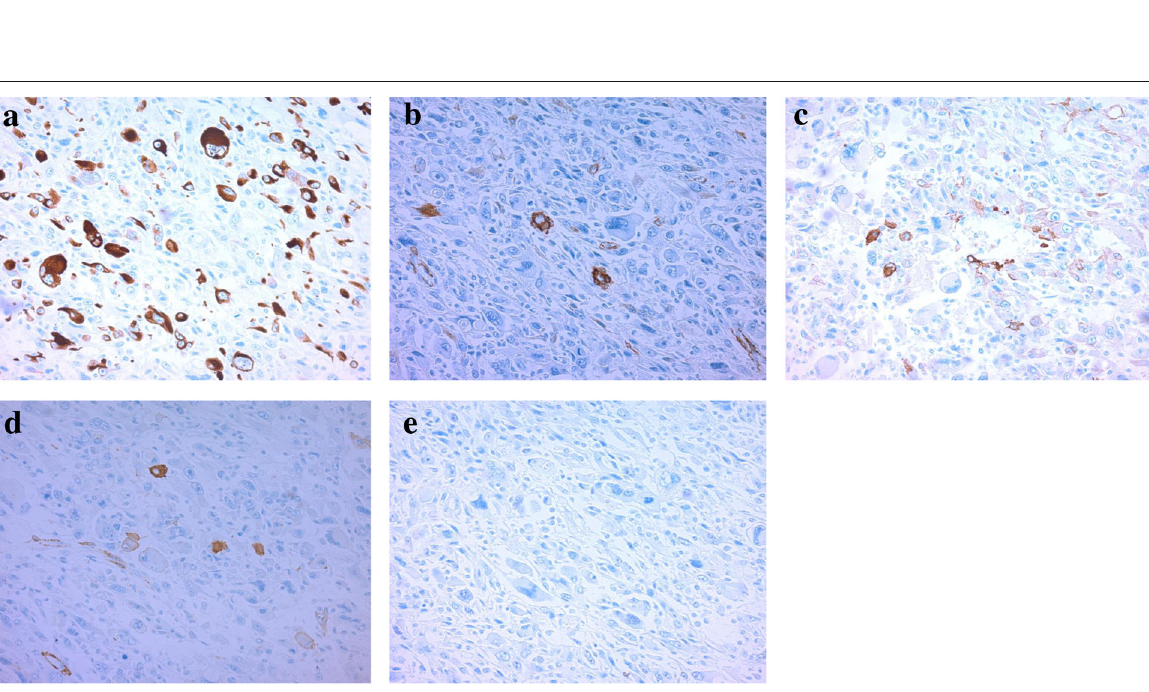
Fig. 7 Immunohistochemical findings. Desmin was positive ( a , ×200), α -smooth muscle actin ( α -SMA) was slightly positive ( b , ×200), and heavy- caldesmon ( c , ×200) and muscle actin (HHF35) ( d , ×200) was positive in 30% of the tumor tissue. Myogenic differentiation 1 (MyoD1) ( e , ×200) did not present significant